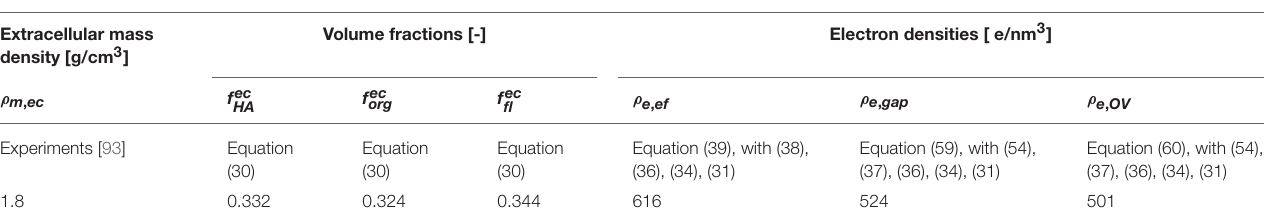
TABLE 1 | Characteristic compositional values of the shad fish bone ultrastructure. Extracellular mass density [g/cm 3 ]